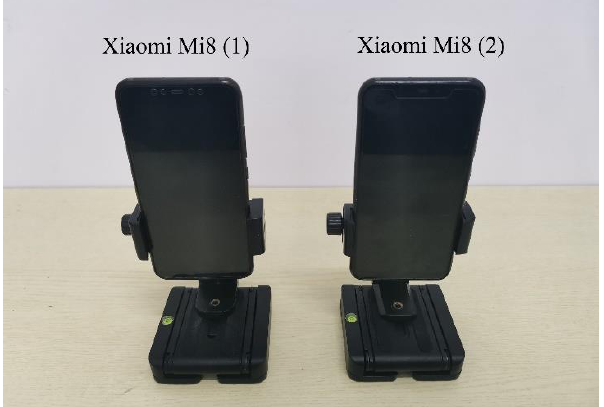
Figure 15. Two smartphones for the SPP experiment.